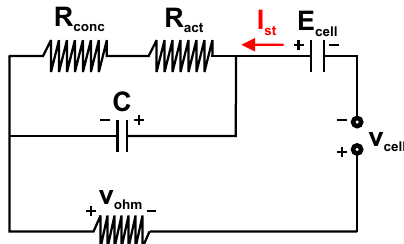
Figure 8. Equivalent electrical circuit of the